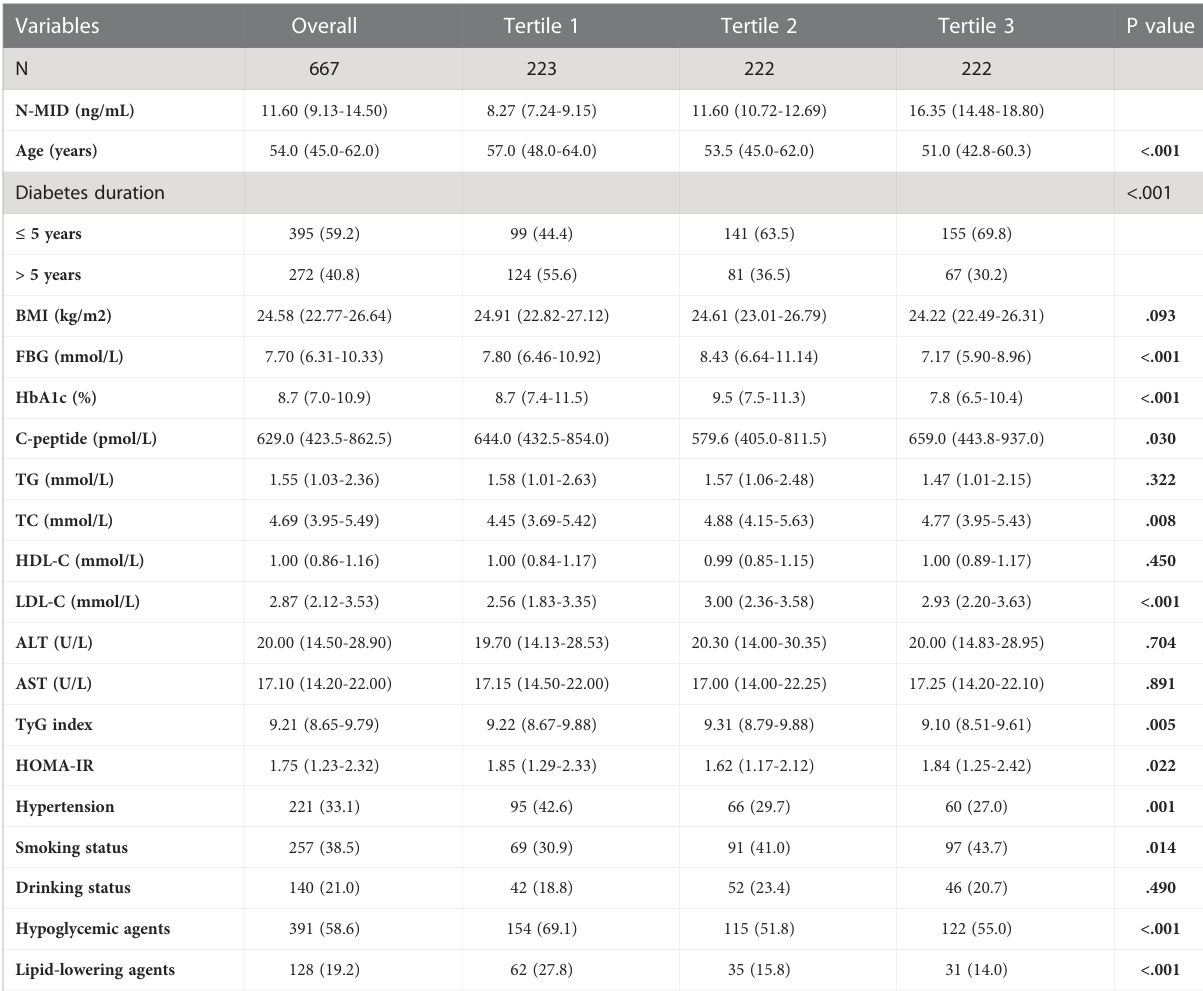
TABLE 1 Clinical characteristics of the study population according to the tertiles of N-MID.